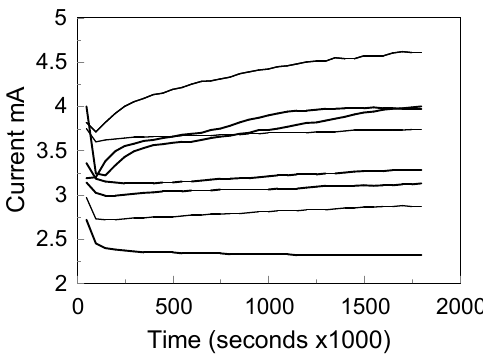
Figure 24. Potentiostatic polarization curves before the fracture of the pin, in the case of the link/welded pin assembly. Sample #4.